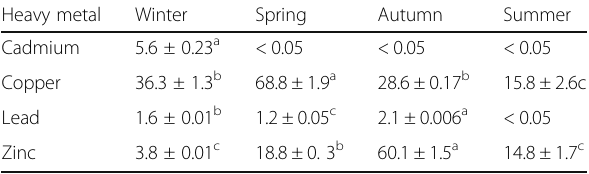
Table 4 Seasonal variations of heavy metals concentrations ( μ